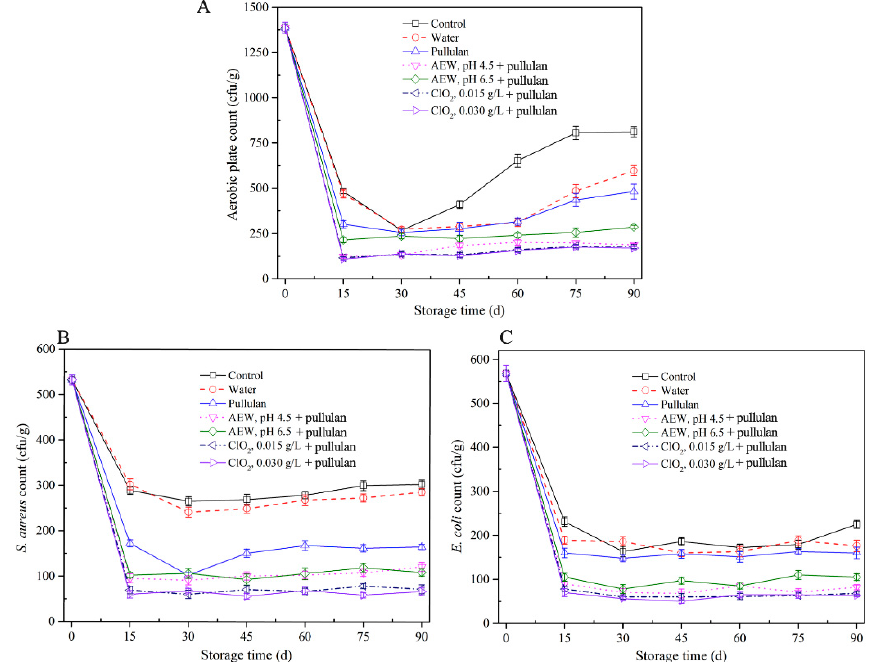
Figure 1. Microbiological properties of half-shell mussels treated with the control, water, and combined glazing solutions during 90 days of frozen storage. ( A ) aerobic plate counts; ( B ) E. coli counts; ( C ) S. aureus counts.